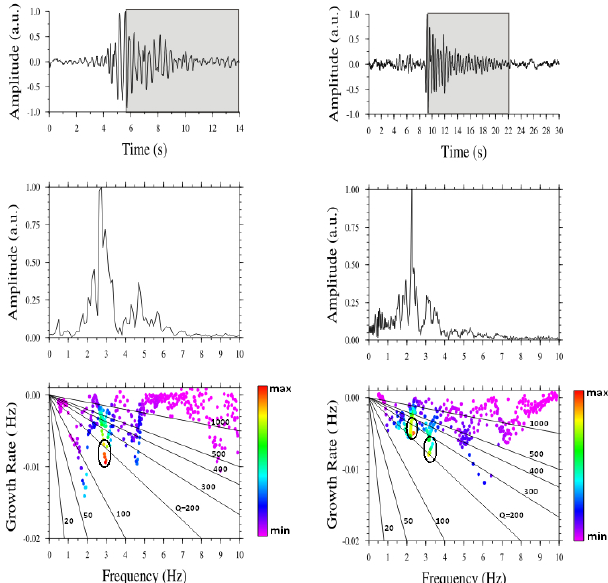
Fig. 9. Examples of results obtained after the application of the Sompi method to LF events #1 and #2 (see Table 1). Top panel: velocity waveforms where the gray shaded part is the one used for the calculation of the complex frequencies. Middle panel: Fourier amplitude spectra of the time windows shown above. Lower panel: Growth rate – frequency diagrams where circled areas indicate high-amplitude wave elements according to the color scale shown at the right (see text for more details). Solid black lines represent constant Q lines for a range of values (20–1000).